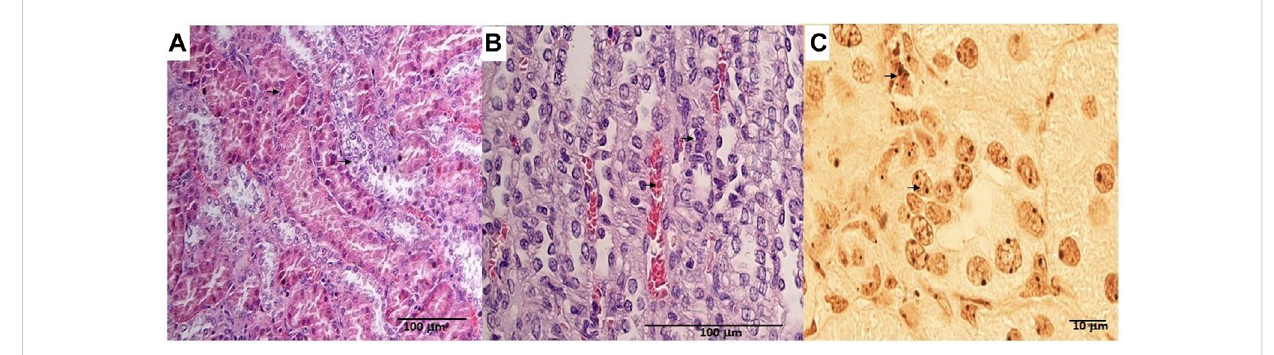
FIGURE 1 (A) Degenerated proximal and distal convoluted tubules, thickened basement membrane, a clear nucleus with karyomegaly (up arrow), and prominent or absent nucleoli in the rat tumor renal section (down arrow). H.E. bar = 100 μ m, 20X. (B) Tumor apical portion of the pyramid: tubules and papillary ducts have cells arranged randomly, cell pleomorphism, high nucleus/cytoplasm ratio (up arrow), prominent nucleoli, and discrete mitosis, rich vascularized (down arrow). H.E. bar = 100 μ m, 40X. (C) AgNor staining of rat renal tumor cells showing prominent nucleus in single cells (arrow). Bar = 10 μ m,